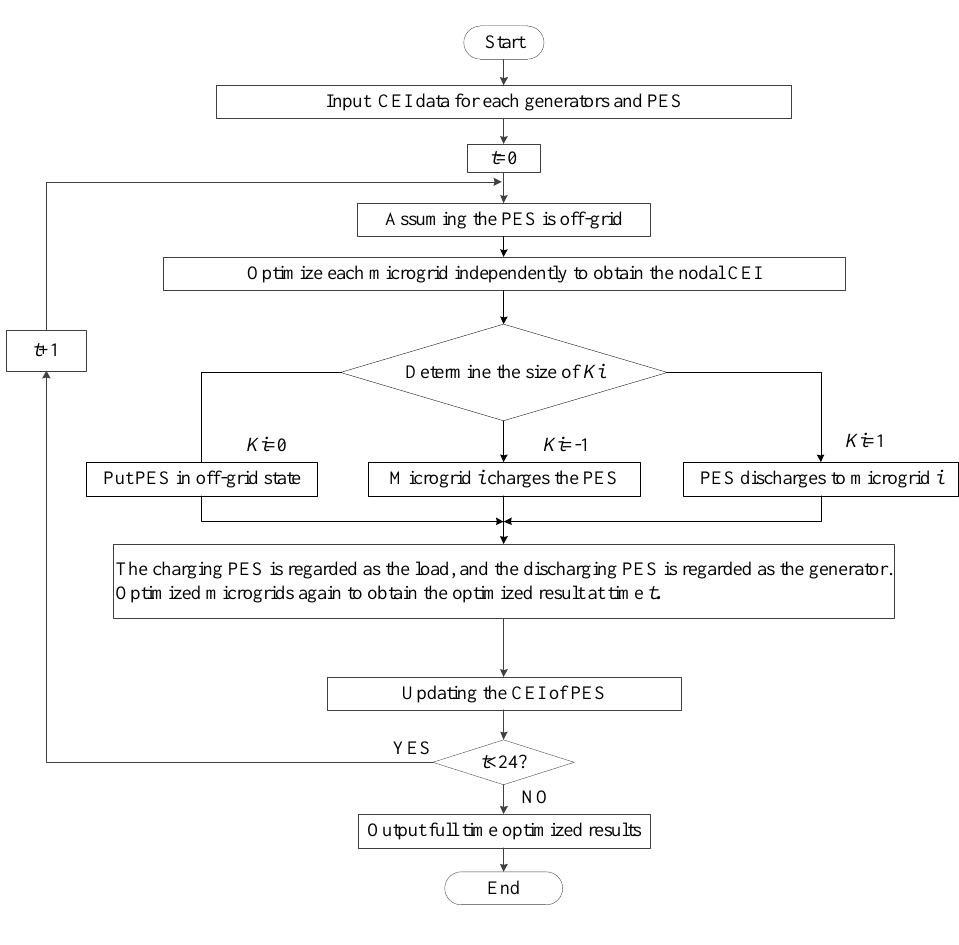
Figure 2. System optimization flow chart.